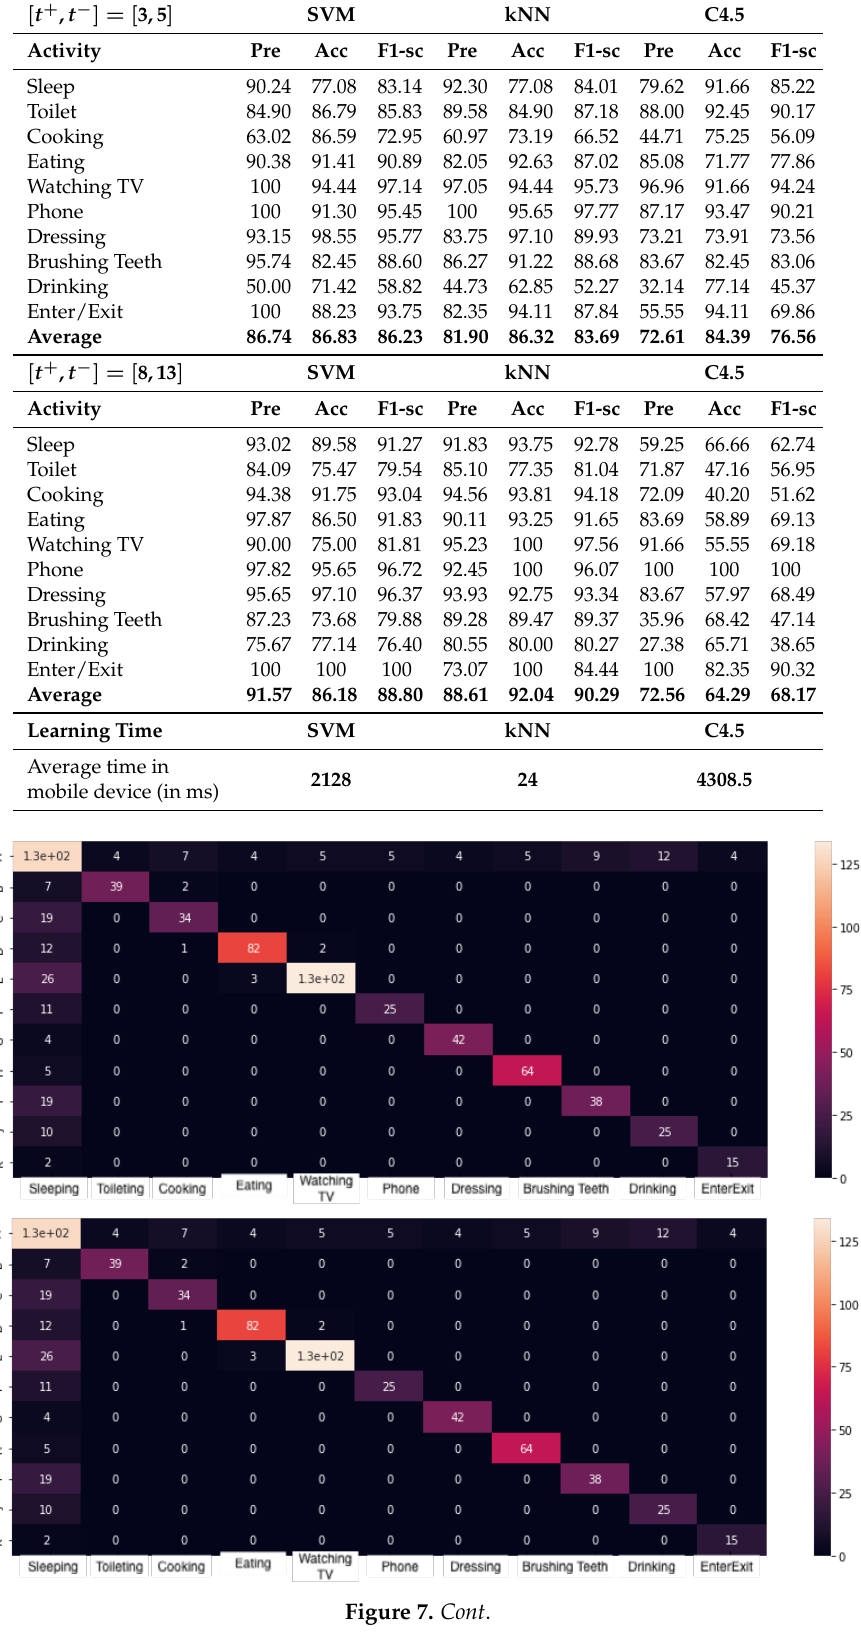
Table 5. Results with fuzzy features (spatial and temporal): precision (Pre), recall (Rec) and F1-score (F1-sc).